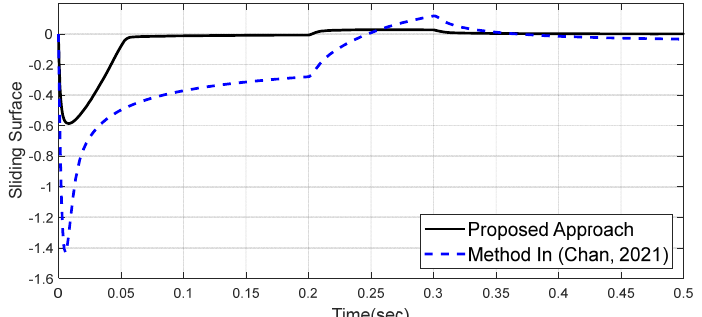
Figure 17. Sliding surfaces [1] .